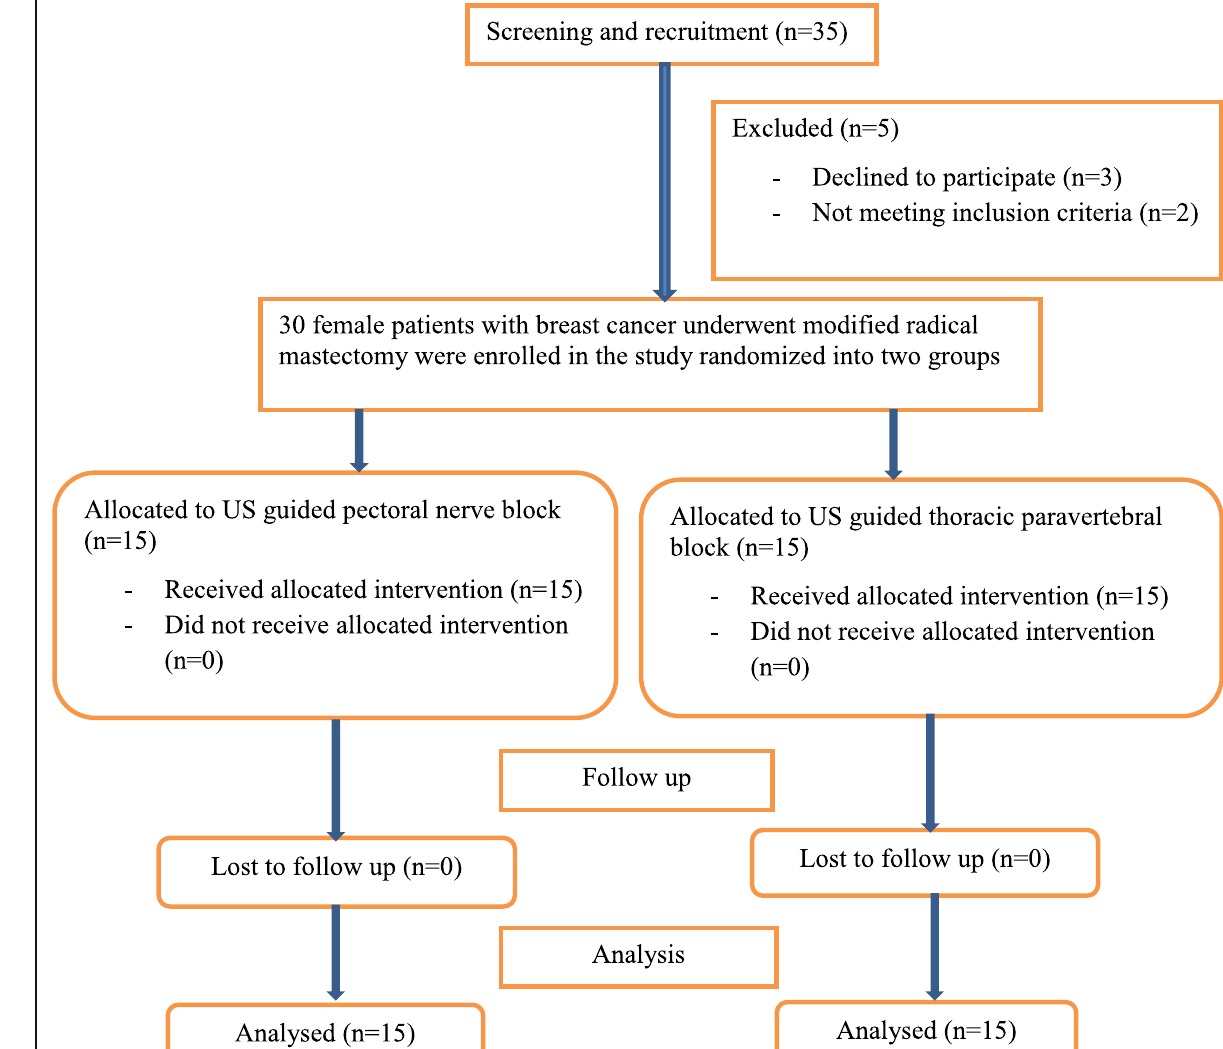
Fig. 1 Consort diagram showing selection and randomization of patients